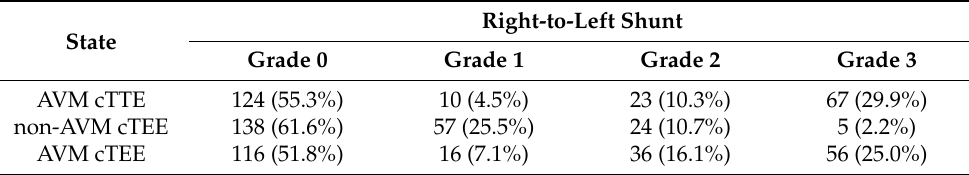
Table 2. The semiquantitative grading of right-to-left shunt under three conditions. Right-to-Left Shunt State Grade 0 Grade 1 Grade 2